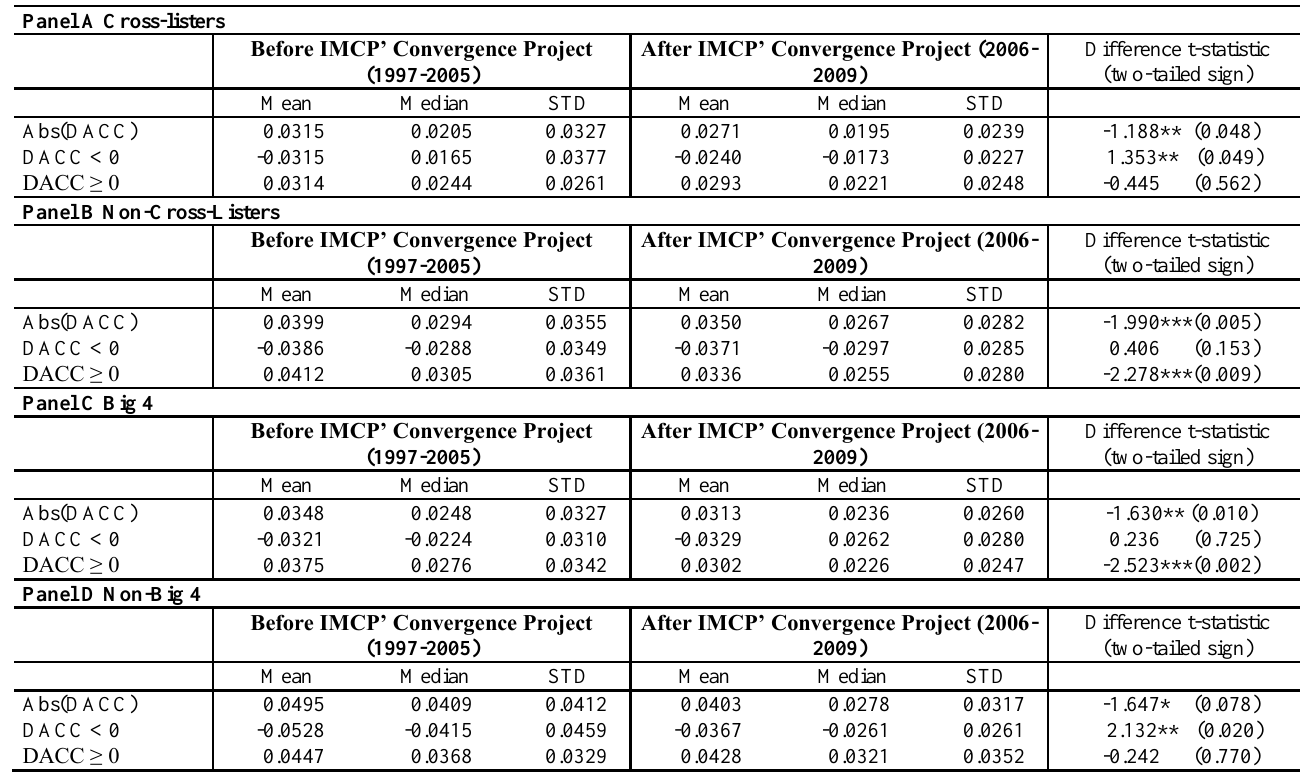
Table 5: Univariate analysis on discretionary accruals Panel A